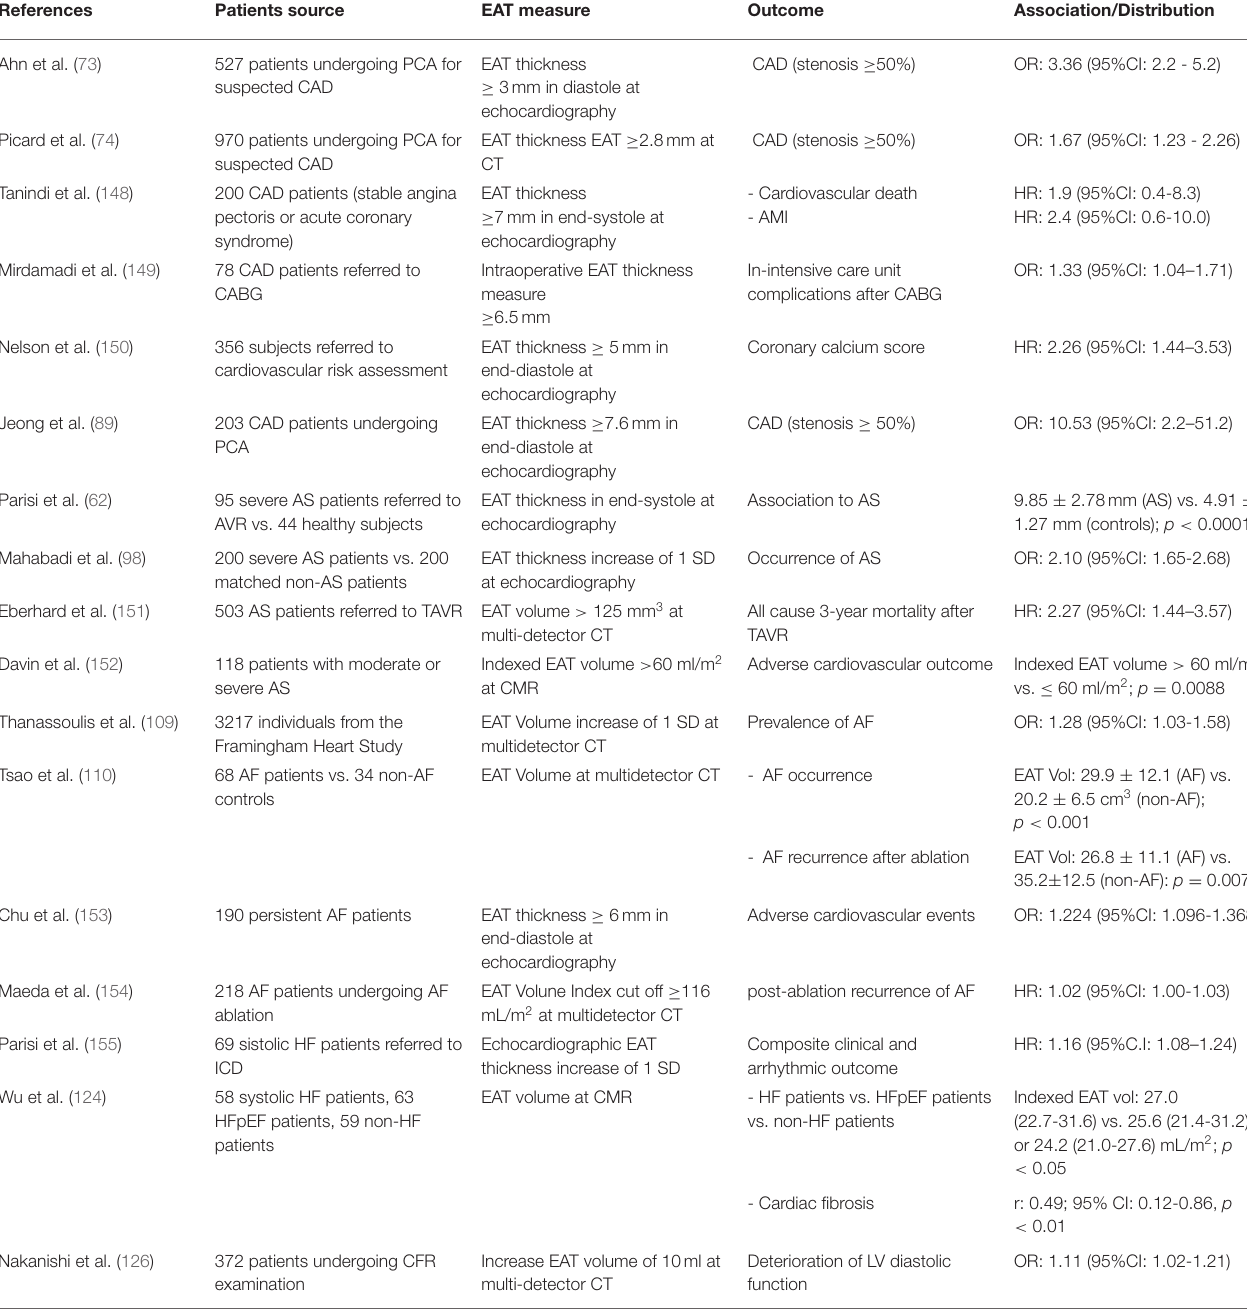
TABLE 1 | Associations between EAT and cardiovascular